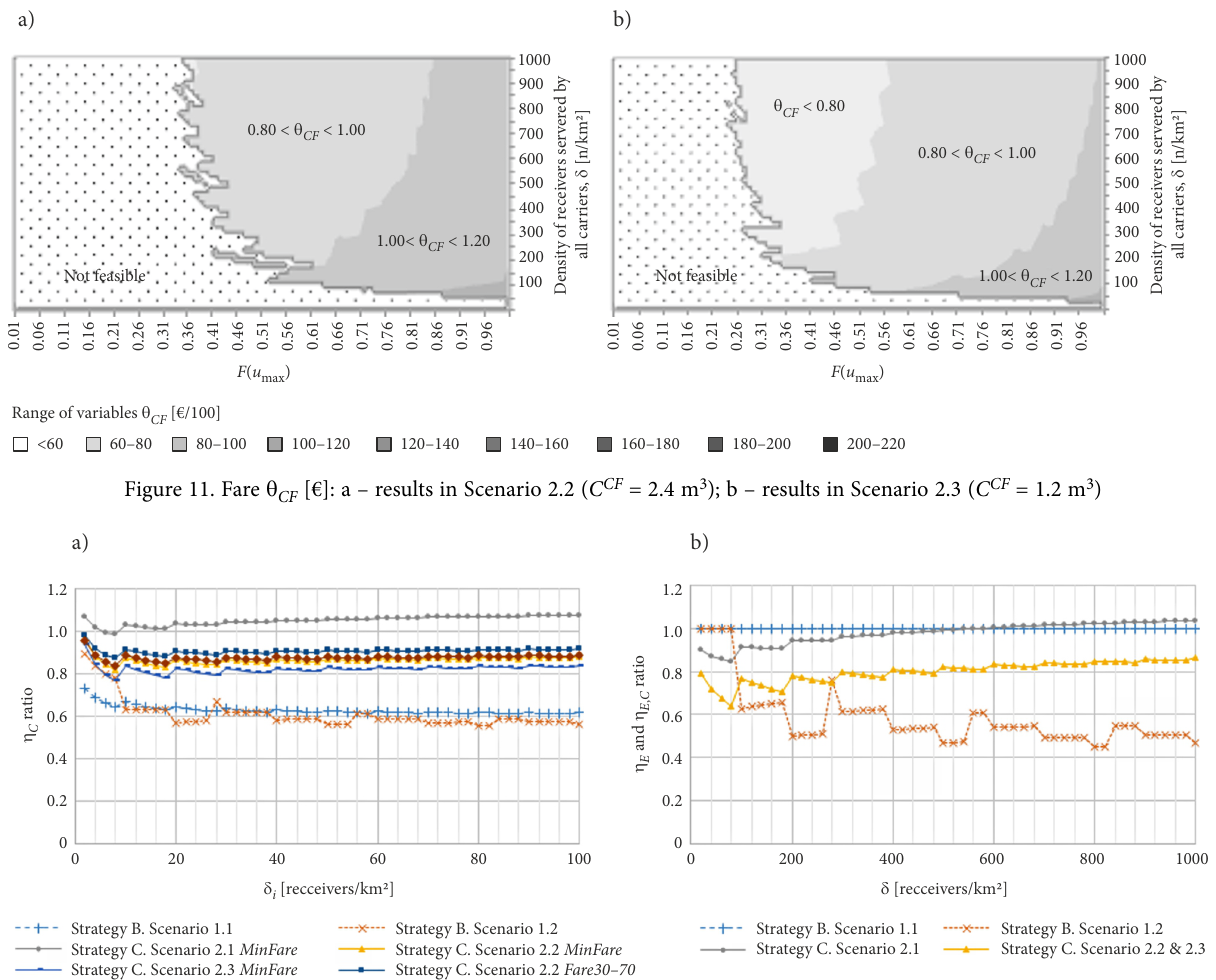
Figure 10. Results in Scenario 2.3 ( C CF = 1.2 m 3 ) with Fare30–70 criterion: a – h C ratio; b – CF operator profitability D CF [€/day]